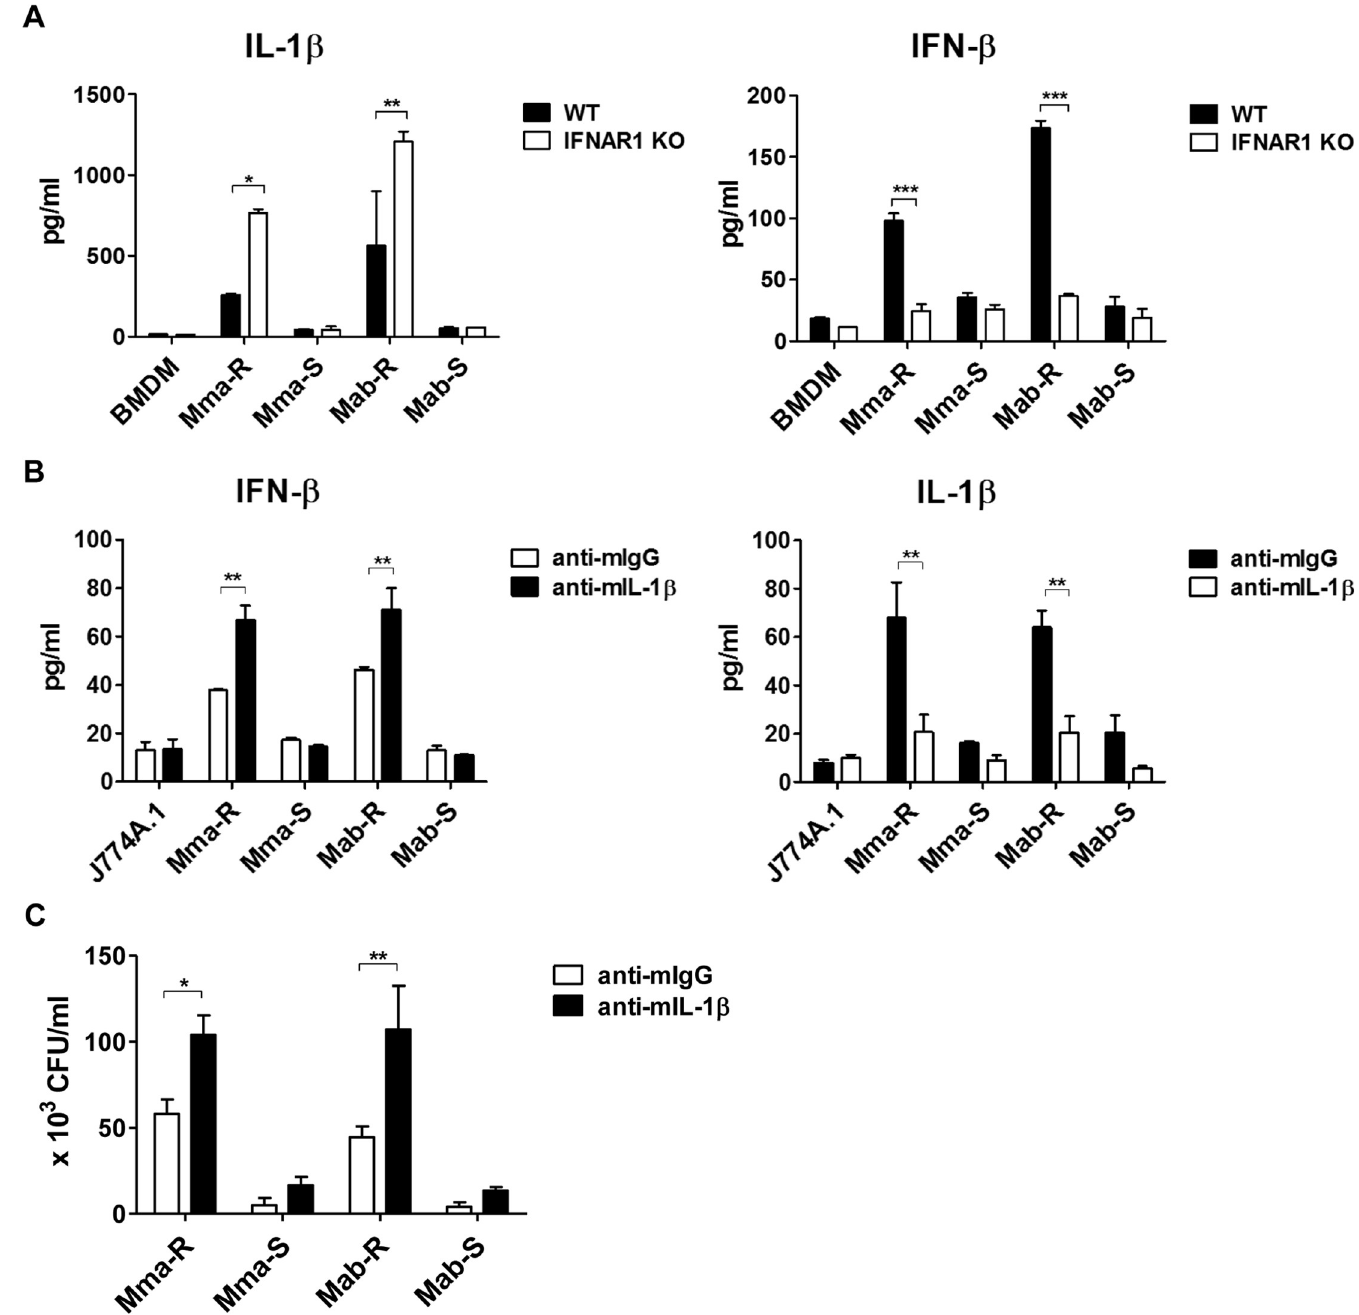
Fig 7. Crosstalk between IFN-I and IL-1 β in MAB-R infection of murine macrophages. (A) BMDMs were obtained from wild-type (WT) or IFNAR1 KO mice and infected with MAB-R and -S strains at an M.O.I. of 10 for 24 h. Supernatants from the infected cells were collected, and IL-1 β and IFN- β cytokine levels were measured by ELISA. (B-C) BMDMs were treated with anti-mouse IgG (10 μ g/ml) or anti-mouse IL-1 β receptor (10 μ g/ml) neutralizing antibodies. Then, the cells were infected with MAB-R and -S stains at an M.O.I. of 10 for 24 h. IL-1 β and IFN- β cytokine levels in the infected cell supernatants were measured by ELISA (B), and infected cell lysates were serially diluted and plated onto 7H10 agar plates for CFU assays (C). Error bars represent the SD. Statistical significance was determined by two-tailed Student’s t -test (A-C).